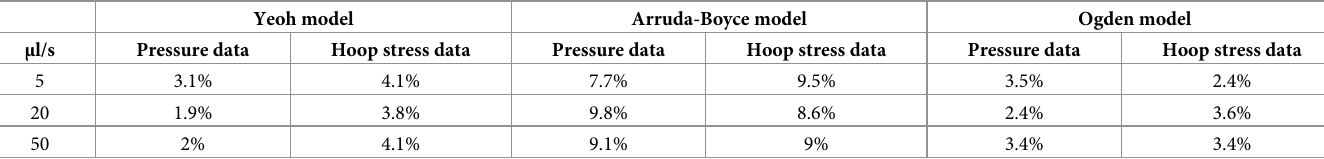
Table 3. RMS error values for each of the